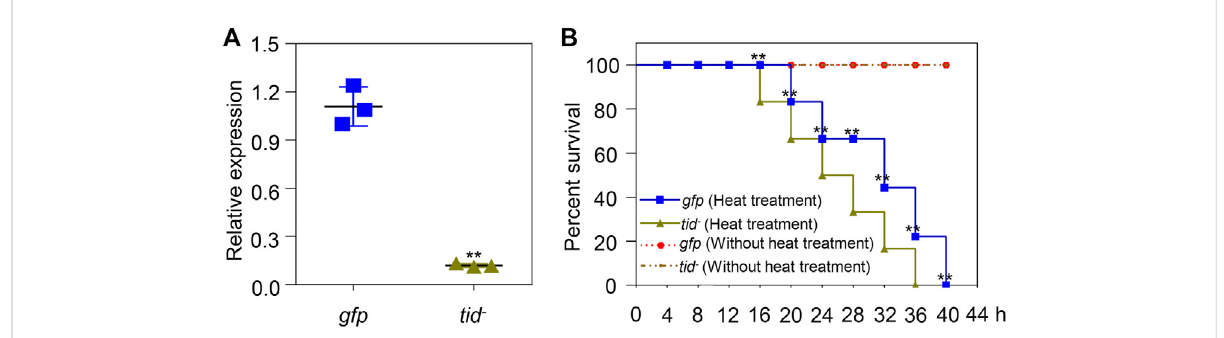
FIGURE 7 Validation of the ef fi ciency of AccTid knockdown (A) , and the impact of silencing AccTid on honeybee heat tolerance (B) . The ef fi ciency of AccTid knockdown was detected using qRT – PCR, and β -actin was used as an internal control. The abbreviations tid − and gfp indicate AccTid knockdown and the GFP control, respectively. ** p < .01 indicates signi fi cant differences according to Student ’ s t -test. Signi fi cant differences between gfp heat treatment group and tid − heat treatment group in (B) are denoted with black